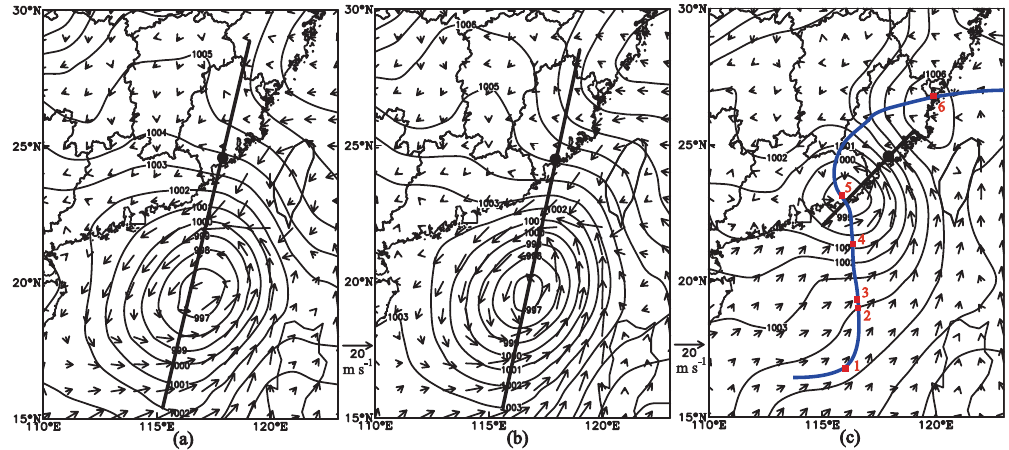
Figure 2. Sea-level air pressure (hPa, contour lines) and 1000hPa wind vectors of NCEP-FNL data, at (a) 14:00 13 June, (b) 20:00 13 June and (c) 20:00 15 June 2014 with black dots representing XQR location. Three straight lines link XQR and the centers of Typhoon Hagibis. The blue curve with the red dots and numbers from 1 to 6 in panel (c) indicate the typhoon track with the center locations at 02:00 12 June, 14:00 13 June, 20:00 13 June, 08:00 15 June, 20:00 15 June and 20:00 16 June (local time)